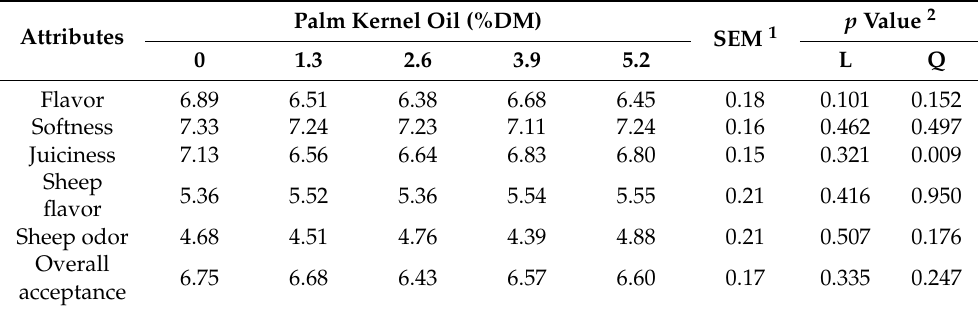
Table 5. Sensorial parameters of Longissimus lumborum muscle of the lambs fed with diets containing different levels of palm kernel